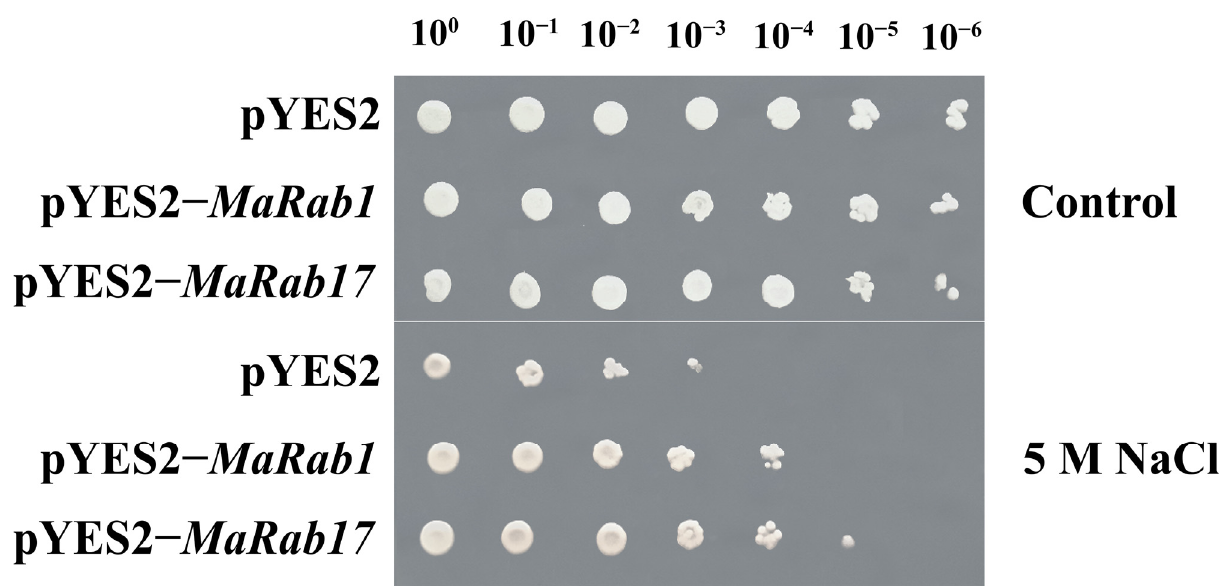
Figure 9. Analysis of NaCl treatment of MaRab1 and MaRab17 genes in yeast heterologous expression compared to the blank pYES2 line. After 36 h of resuspension under control and 5 M NaCl, consecutive dilutions (10 0 , 10 − 1 , 10 − 2 , 10 − 3 , 10 − 4 , 10 − 5 , 10 − 6 ) of yeast were spotted onto SC − Ura solid medium. Sterile water was used as the control.